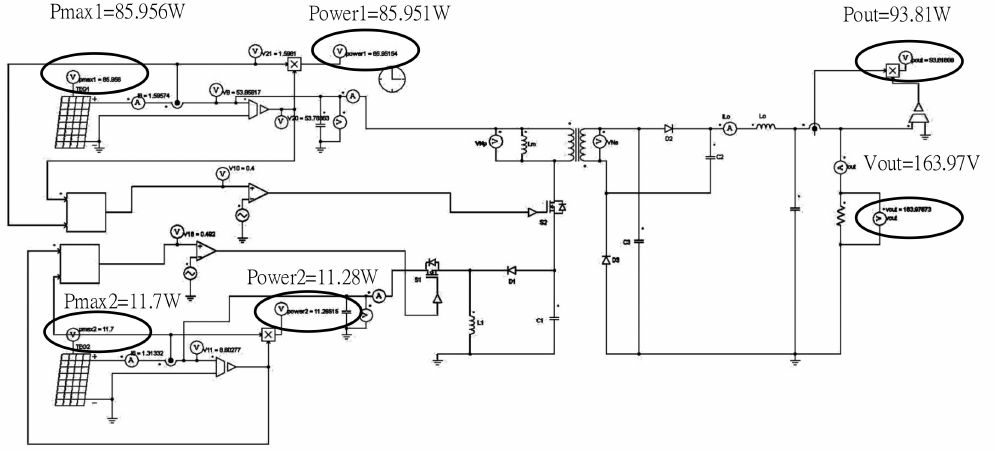
Figure 19. Simulation example